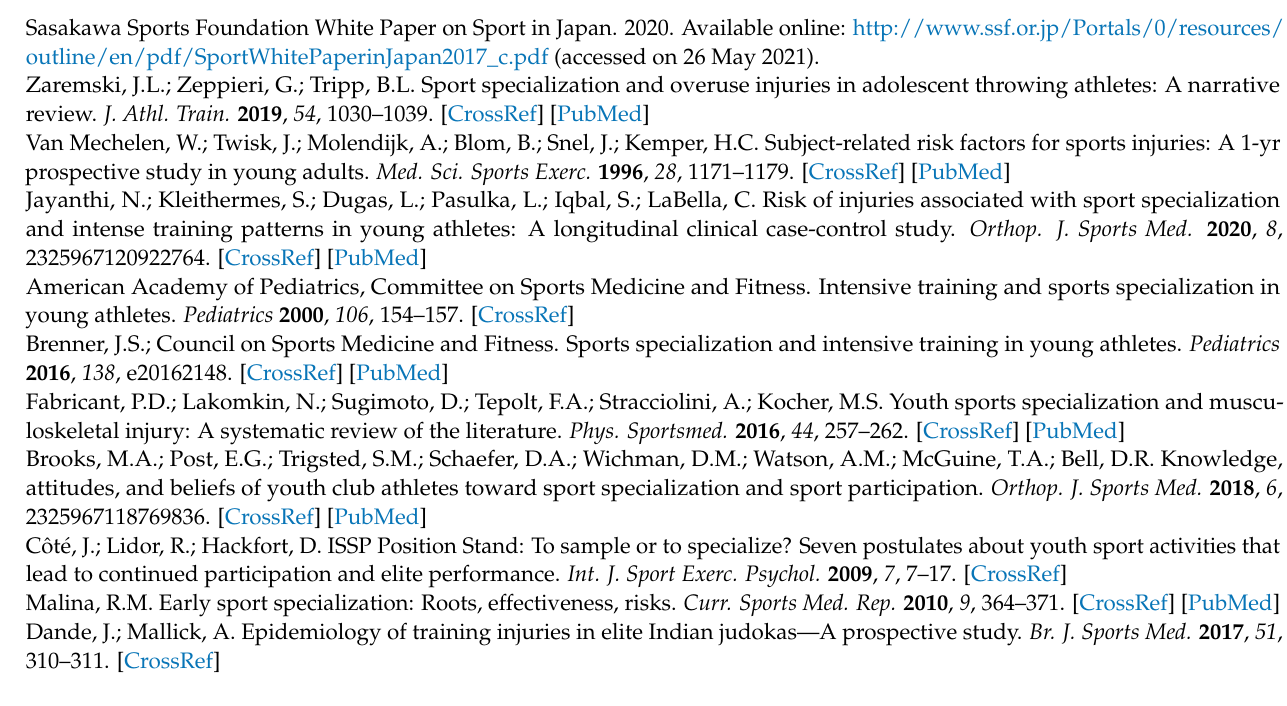
Table S2: Number (%) of those with experience and those with injury in each sports item, and Figure S1: Number of sports items adopted by each participant in each school